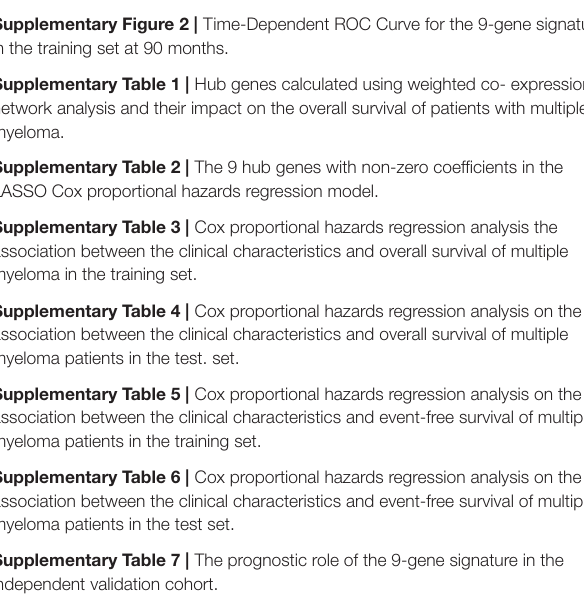
Supplementary Figure 1 | Flowchart depicting the major process of Co-expression network construction and identification of hub genes. Supplementary Figure 2 | Time-Dependent ROC Curve for the 9-gene signature in the training set at 90 months. Supplementary Table 1 | Hub genes calculated using weighted co- expression network analysis and their impact on the overall survival of patients with multiple myeloma.